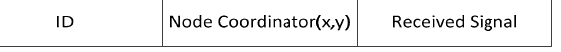
( b ) Figure 5. APIT localization test principle schematic. ( a ) M is in the triangle; ( b ) M is out of the triangle.